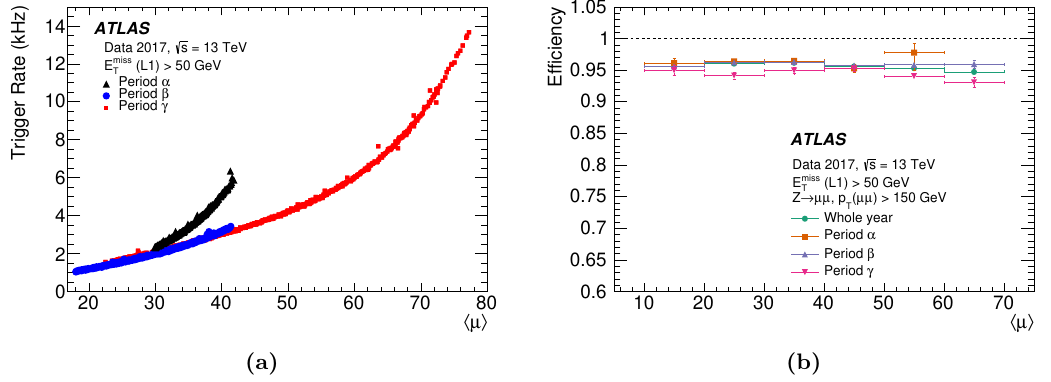
Figure 4. (a) The L1 E miss trigger rate as a function of h (cid:22) i for runs in three di(cid:11)erent periods ( (cid:11) , T (cid:12) , (cid:13) ) in the year 2017. (b) The L1 E miss trigger e(cid:14)ciency is shown as a function of mean pile-up for T events satisfying a Z ! (cid:22)(cid:22) selection and with p T ( (cid:22)(cid:22) ) larger than 150 GeV in three periods during the year 2017. The uncertainties are